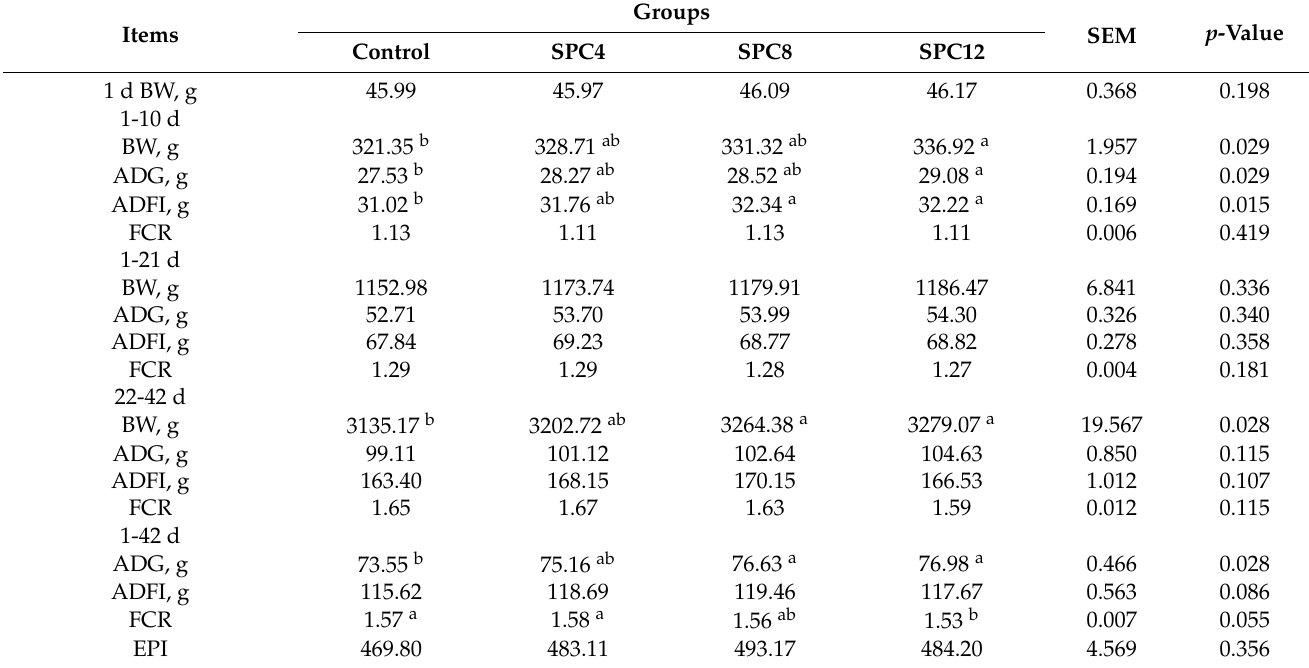
Table 3. Effects of dietary soy protein concentrate (SPC) in starter diet on growth performance of broilers.